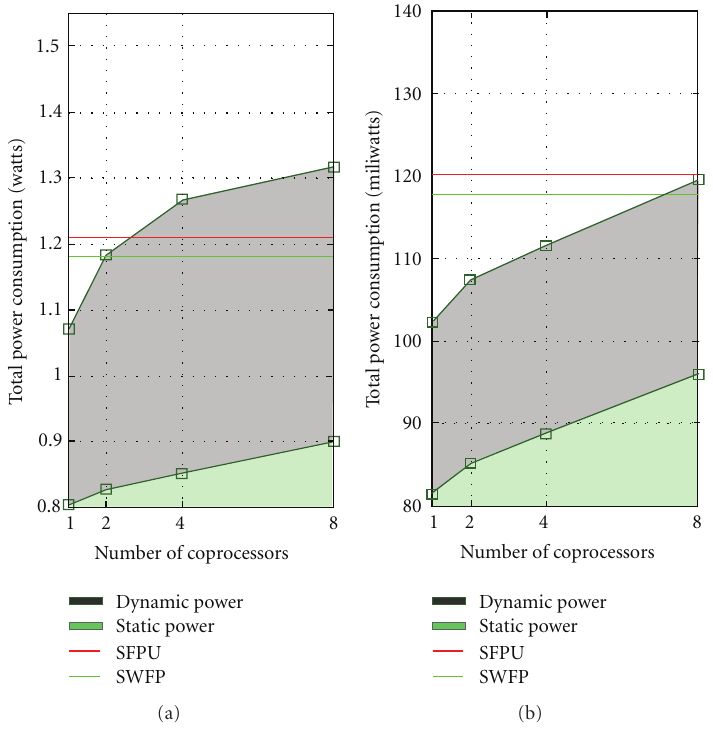
Figure 14: Virtex II Pro (a) and Virtex 4 (b) total power consumption (dynamic + static).